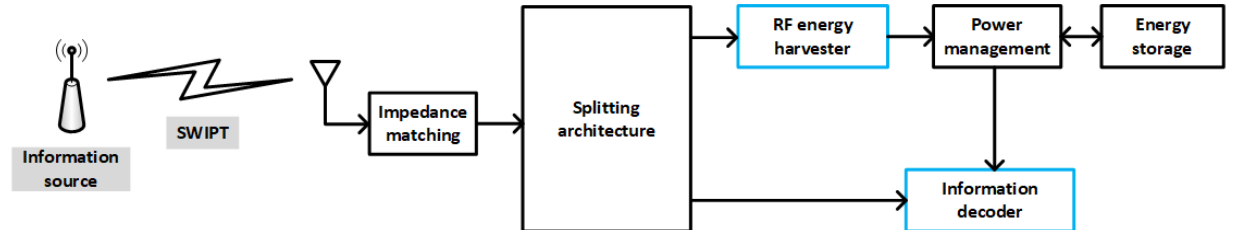
Figure 2. SWIPT scenario. Power is obtained from the same information signal, by using a splitting architecture that generates an input for every independent